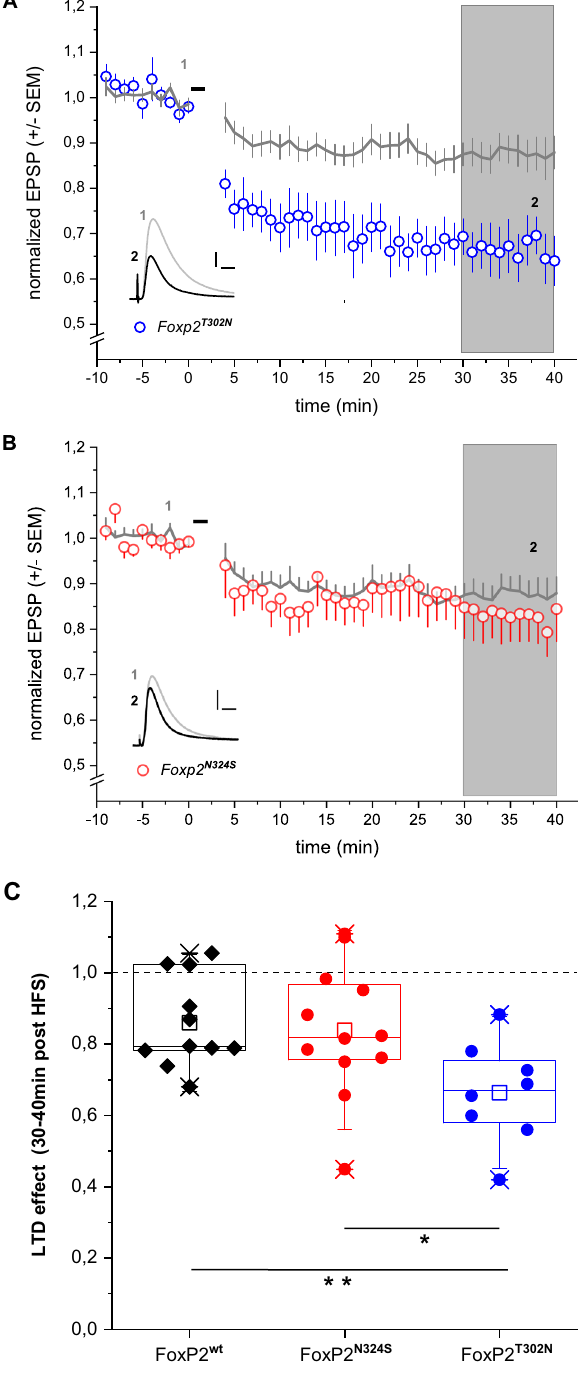
Figure 2. Effects of human amino acid substitutions in FOXP2 on synaptic plasticity in striatal neurons in ( A ) Foxp2 T302N mice and ( B ) Foxp2 N324S mice. LTD was induced in MSN by high-frequency stimulation (100 Hz, black bars; see “Experimental procedures”). Amplitudes normalized to baseline levels (mean ± SEM, t = 10 to 0) is shown. Insets in A and B show representative EPSP traces averaged over 5 min at time point 1 (pre high- frequency stimulation) and 2 (post high-frequency stimulation, scale bars 2 mV, 20 ms). For comparison, mean amplitudes for wild-type ( Foxp2 wt , grey line) are given in A and B. Boxplots in ( C ) illustrate the LTD effect for each strain (average reduction of EPSP amplitude t = 30–40 min compared to baseline (t = − 10 to 0 min, *P = 0,028, **P = 0,011,